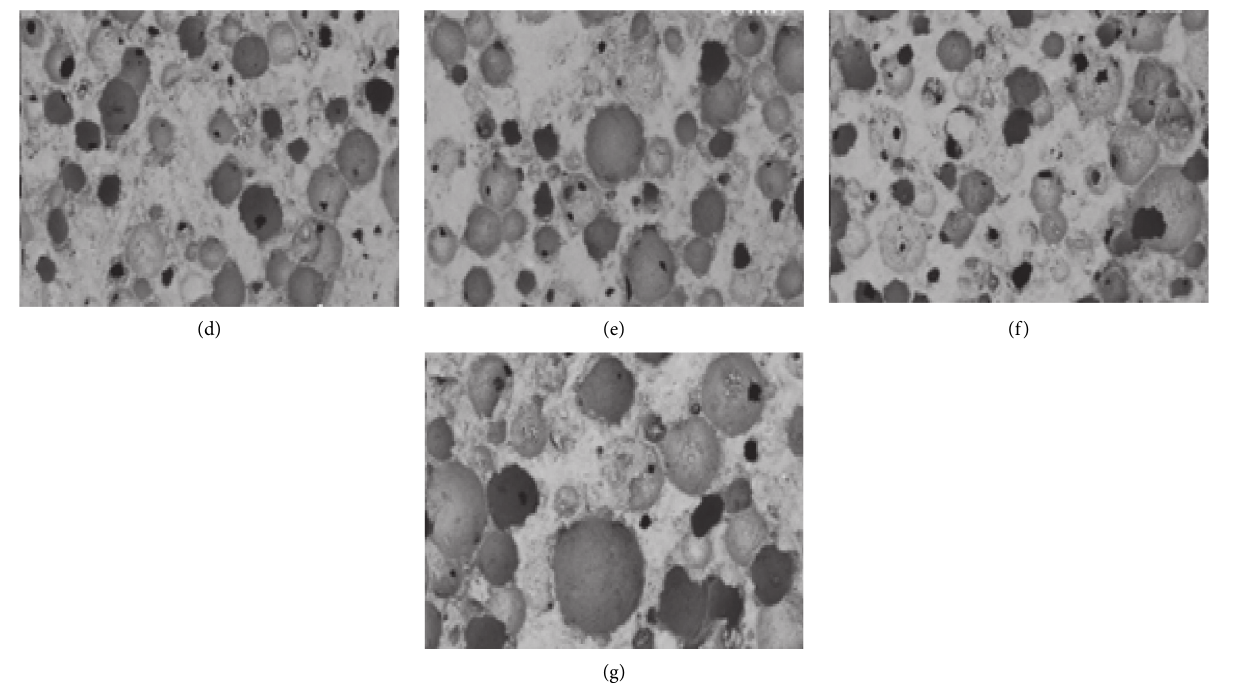
Figure 14: SEM images of foamed concrete prepared with different volumes of foaming agent solution: (a) 40mL; (b) 50 mL; (c) 60mL; (d) 70mL; (e) 80 mL; (f) 90 mL; (g) 100mL.